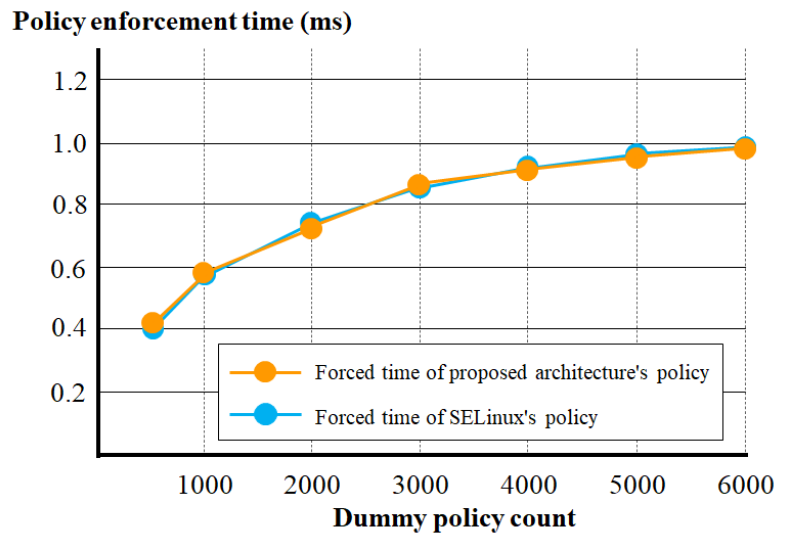
Figure 10. Security policy enforcement times of SELinux and the proposed architecture.